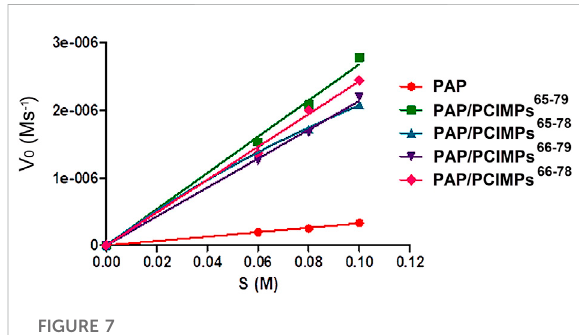
FIGURE 7 Michaelis – Menten plot of PAP and PAP/PCIMPs obtained with various concentrations of